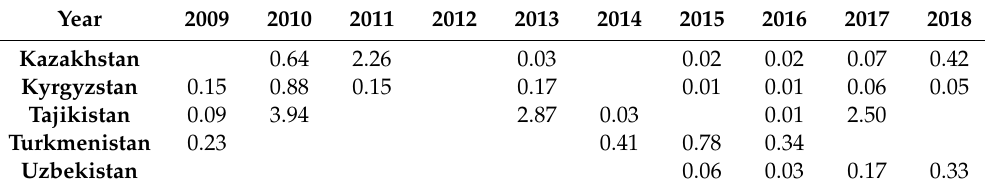
Table A5. Share of NHRE in Total ODA, % (Source: author, based on Creditor Reporting System,